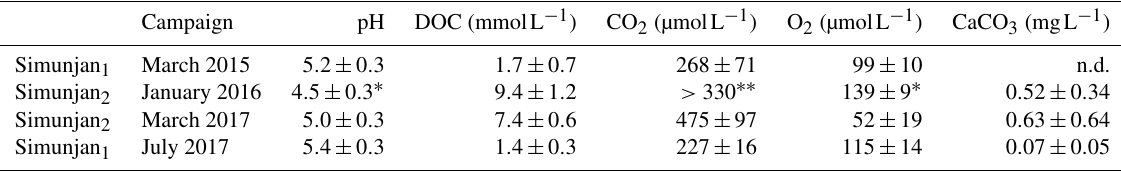
Table 4. Data measured in the four Simunjan campaigns.